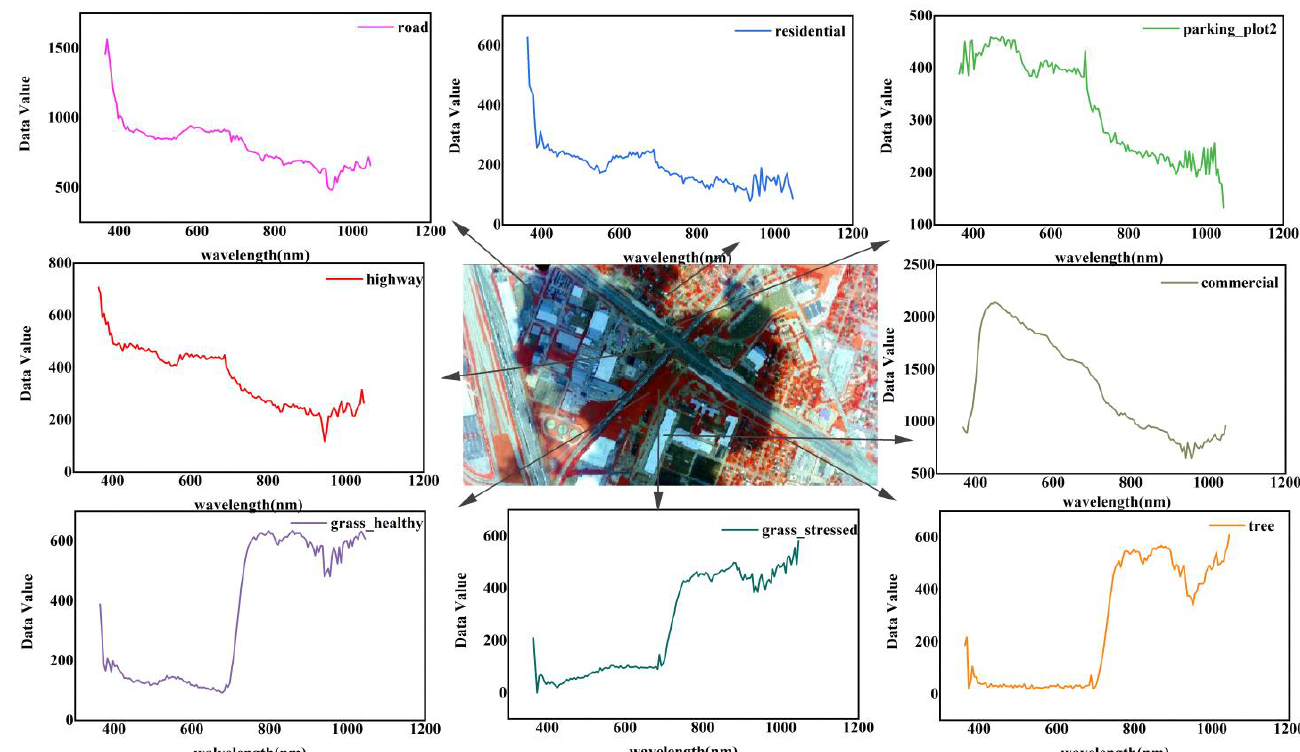
Figure 16. Spectral curves of classes in the cloud shadow area.